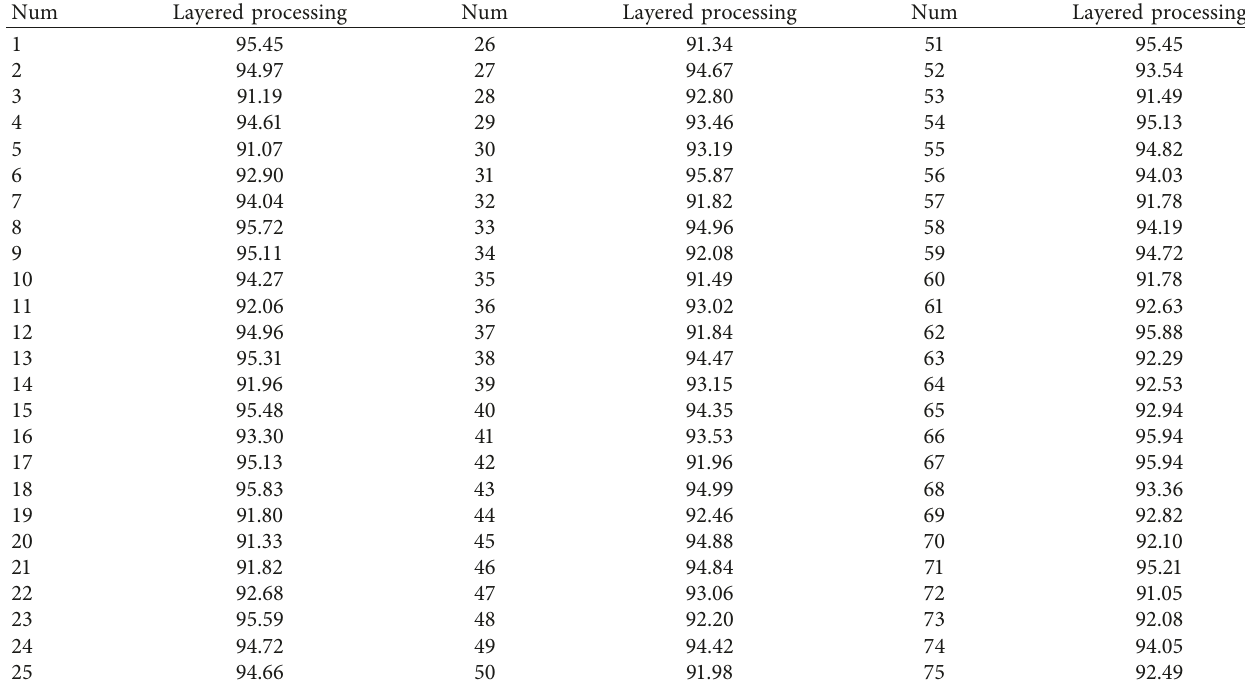
Table 1: The hierarchical processing effect of the hierarchical retrieval model of digital English teaching information based on ontology. Num Layered